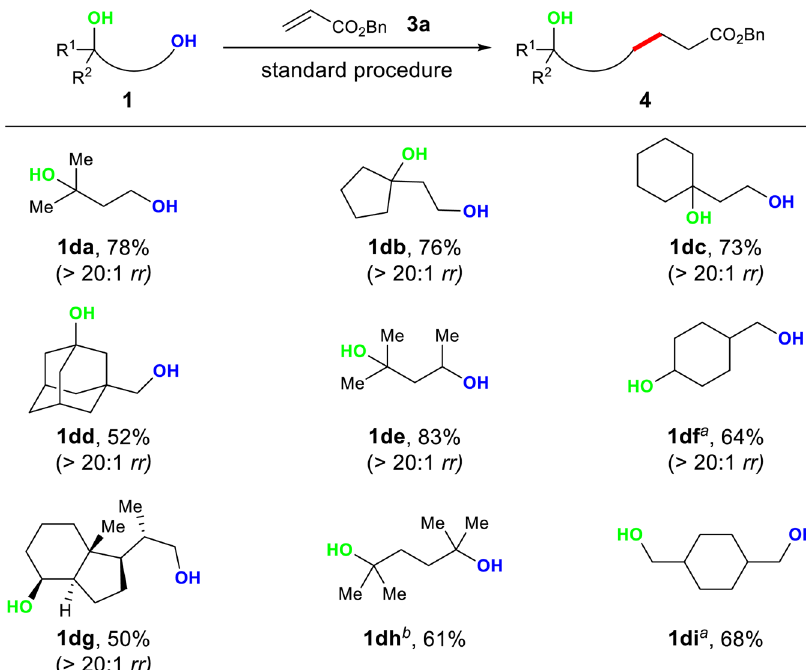
Fig. 4 Selective deoxygenative alkylation of diols. The standard procedure is as shown in Table 1. Isolated yields are reported. a 48 h. b NaH as base. Unreacted hydroxyl groups are marked in green. rr regioselectivity ratio.